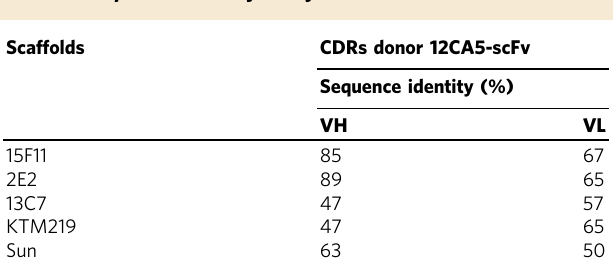
loop grafting the 12CA5-scFv CDRs onto the 15F11 scaffold. To screen our chimeras, we fused each with the monomeric enhanced GFP (mEGFP) and co-transfected each of the resulting plasmids into U2OS cells, together with a plasmid encoding 4 × HA-tagged red fl uorescent protein mCherry fused to histone H2B (4 × HA-mCh-H2B). If a chimeric scFv binds to the HA epitope